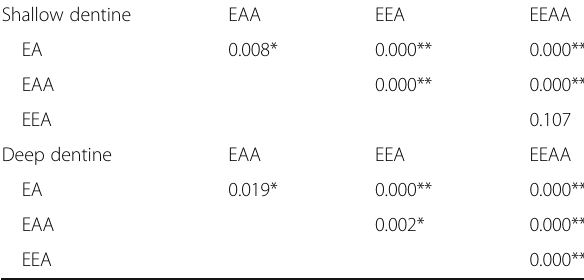
Deep dentine ( n = 24) Resin infiltration protocols